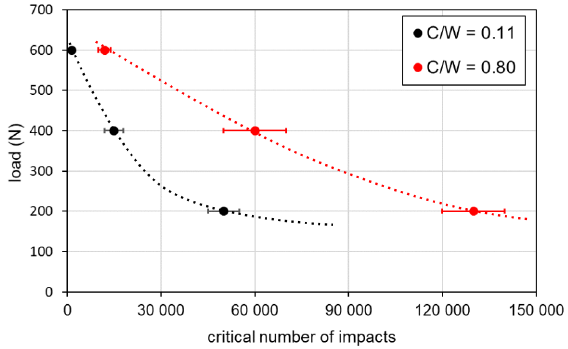
Figure 6. Woehler-like curves of the W-B-C coatings. Dotted lines were added as a visual